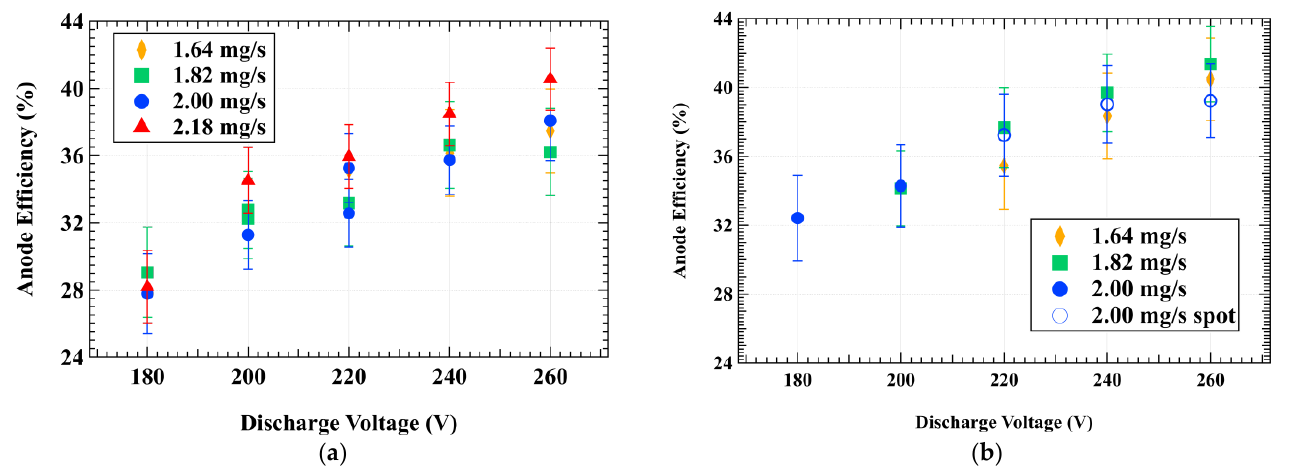
Figure 8. ( a ) Anode efficiency as a function of discharge voltage and anode mass flow rate for 5-s tests; ( b ) anode efficiency for the 15-s tests.